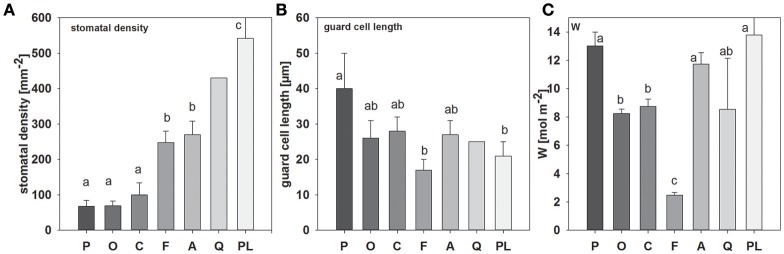
Mean values (±SD, n = 3–5) of (A) stomatal density, (B) guard cell length and (C) leaf water content (W), species-specific gray scale color code is maintained throughout all figures (except Figure 3). Species are sorted as follows: P. abies, O. triangularis, C. arabica, F. sylvatica, A. longifolia, Q. suber, P. lanceolata. Lower case letters indicate statistical differences between species (p < 0.05).